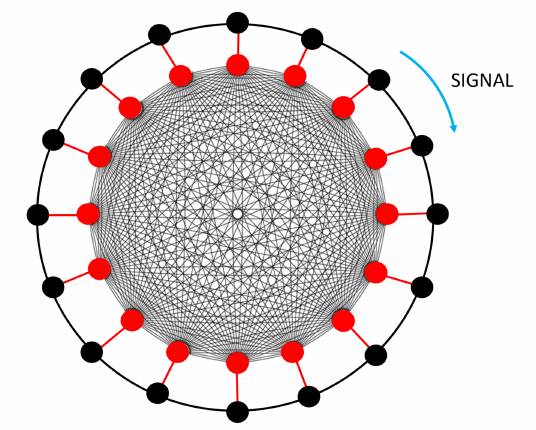
Figure 3 . All-to-all coupled model. The outer black ring plays the role of a simple wire. In the model discussed below, it will correspond to non-interacting Majorana fermions which we also call local Majorana. The inner red ring plays the role of the chaotic non-local shortcut. In the model below, it will correspond to an all-to-all interacting SYK model which we call chaotic Majorana. As in the wire models, the key physical features of this setup are that simple signals continue to obey a local speed limit while complex entanglement will spread